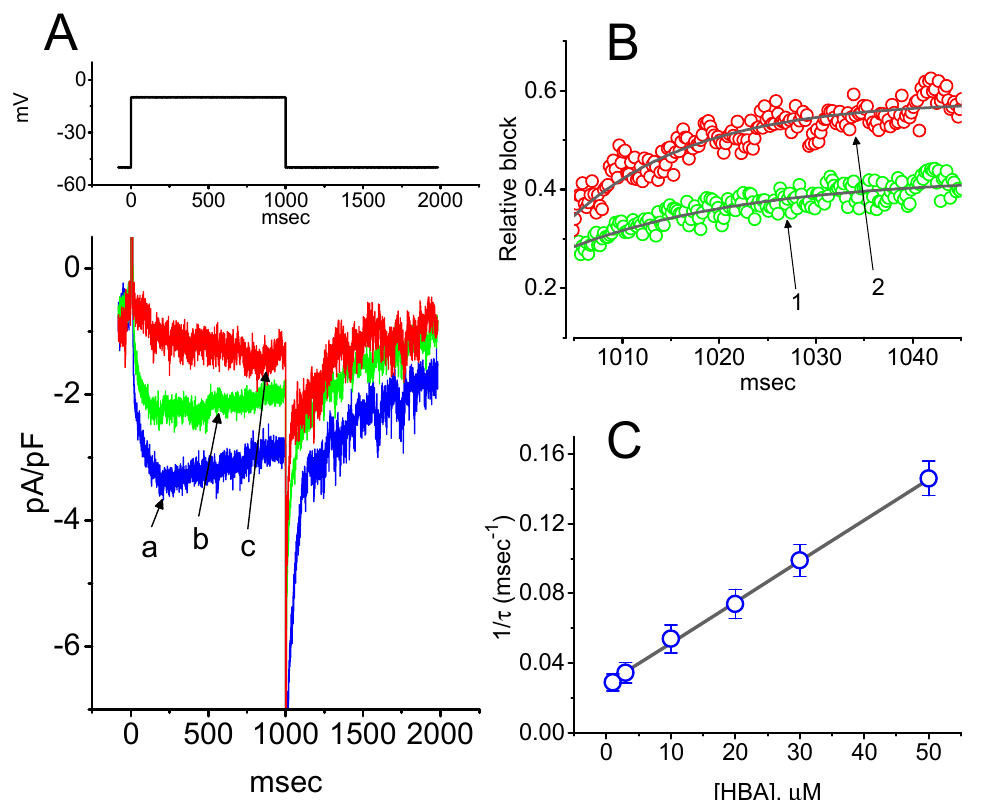
Figure 4. Evaluation of the kinetics of HBA-induced blocking of I K(M) density as elicited by membrane depolarization in the GH 3 cells. The I K(M) density established by depolarizing pulses from − 50 to − 10 mV was measured as cells were exposed to different HBA concentrations (1–50 µ M). ( A ) Representative traces of I K(M) density elicited in response to membrane depolarization from − 50 to − 10 mV (indicated in the upper part) were obtained in the absence (a) and presence of 10 µ M (b) and 30 µ M (c) HBA. In ( B ), the time courses of the relative blocking of deactivating I K(M) -density trajectory by 10 µ M HBA (1) and 30 µ M HBA (2) were well fitted by single exponential with values of 19.0 and 12.9 ms, respectively (indicated by each smooth line). The relative block (i.e., (I control -I HBA )/I control ) was evaluated by dividing the HBA-sensitive current density by the current density obtained in the control. In ( C ), the reciprocal time constant (i.e., 1/ τ ) of relative blocking versus the HBA concentration was plotted. Data points appearing in open circles were well fitted by a linear regression, indicating that there was a molecularity of one. According to the binding scheme described in the Materials and Methods Section, the blocking ( k +1* ) and unblocking ( k -1 ) rate constants for HBA-induced blocking of I K(M) were calculated to be 0.00235 ms − 1 µ M − 1 and 0.028 ms -1 , respectively. Mean ± SEM ( n = 9–11 for each point).